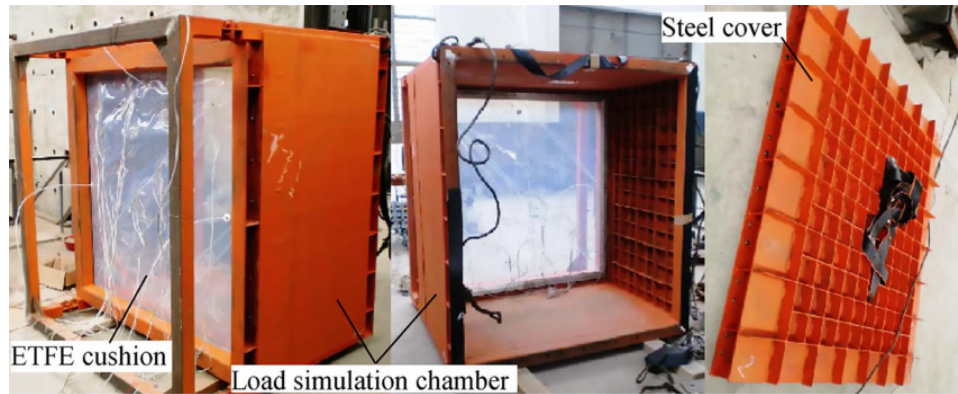
Figure 8. Load simulation device [56].